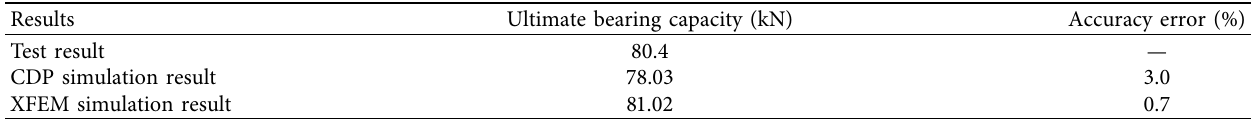
Table 3: Ultimate bearing capacity of simply supported beams.